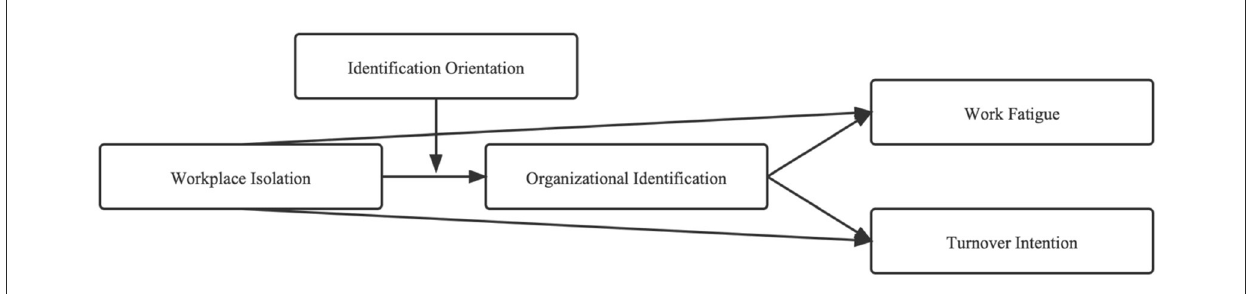
FIGURE1 Research framework–theoretical model.